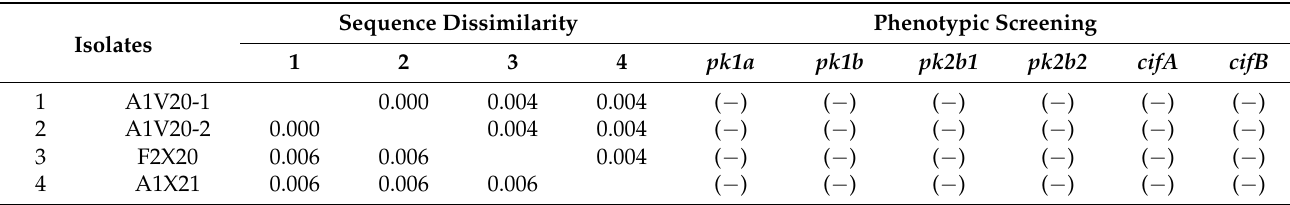
Table 5. Diversity of phage WO ( WOAlec ) and phenotypic